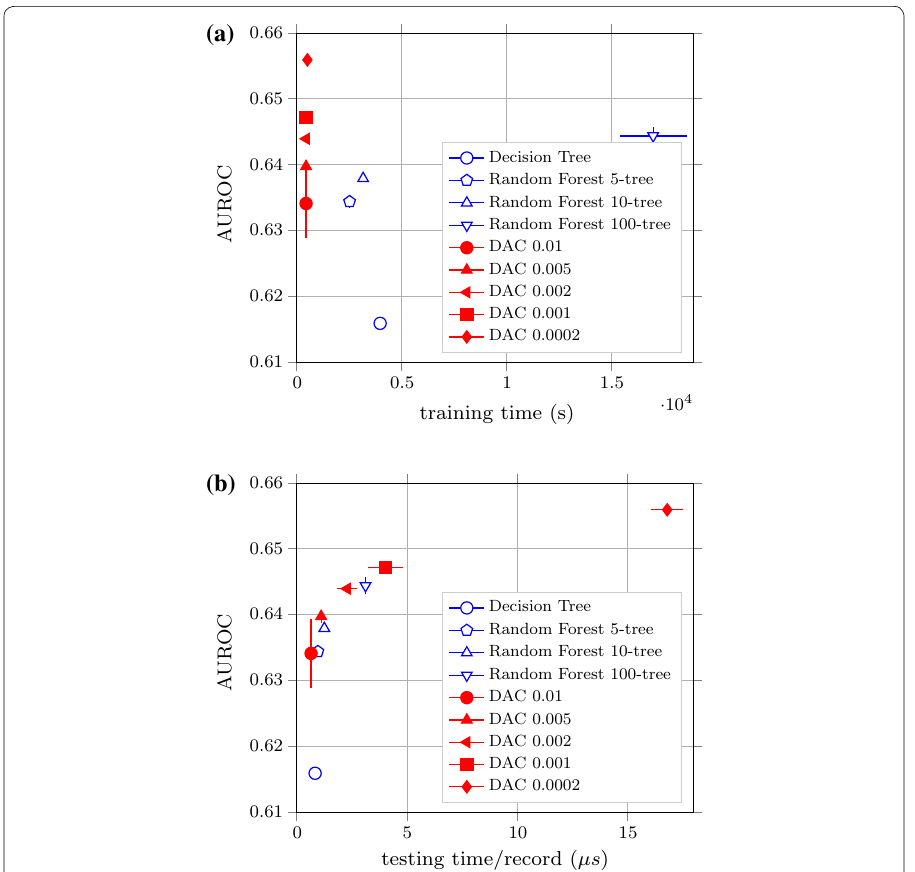
Fig. 5 DAC vs Random Forest. AUROC vs a training and b testing times, cross-validated with fivefold on the entire